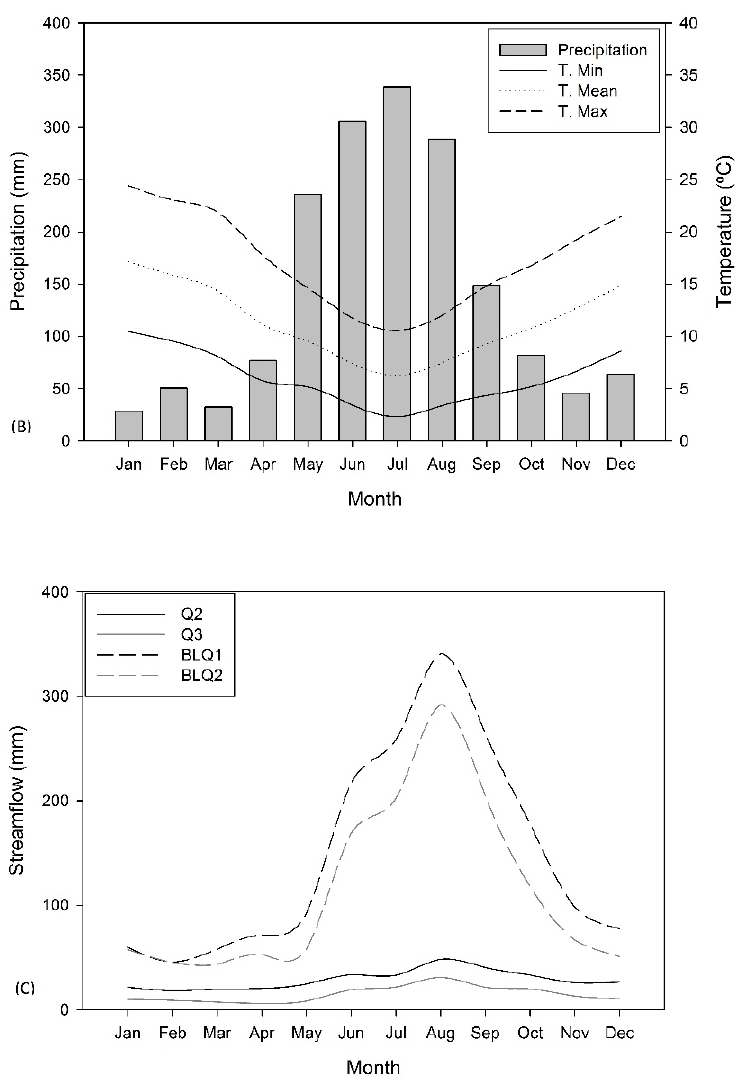
Figure 2. Ombrothermic diagram for the catchments: ( A ) Quivolgo (Q1 and Q2) and ( B ) Bajo las Quemas (BLQ1 and BLQ2), in south-central Chile [68]; and ( C ) mean monthly streamflow for the four catchments. Table 1. Vegetation cover and geomorphological data of surface (ha), exposure ( ◦ ) and slope ( ◦ ) in the catchments. Area Catchment Land